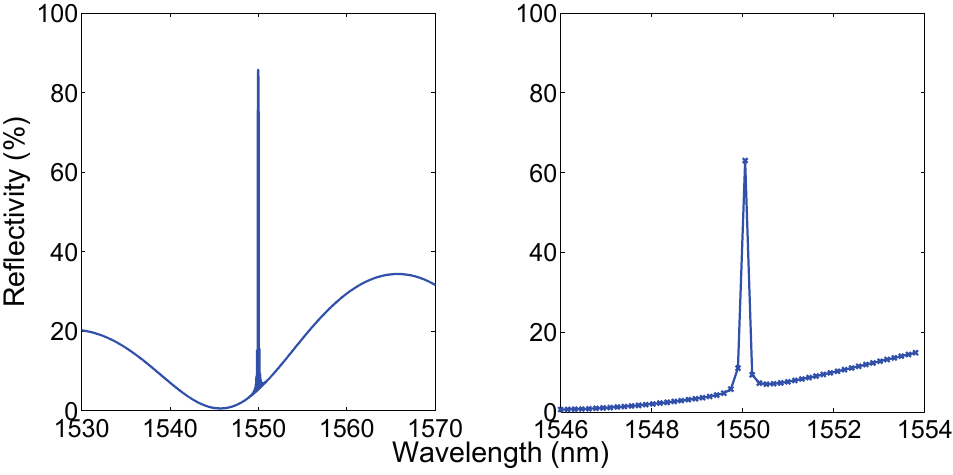
Figure 10. Spectrum of dual EFPI/FBG sensor. ( Left ) original spectrum; ( Right ) spectrum after 156-pm sampling and N -size